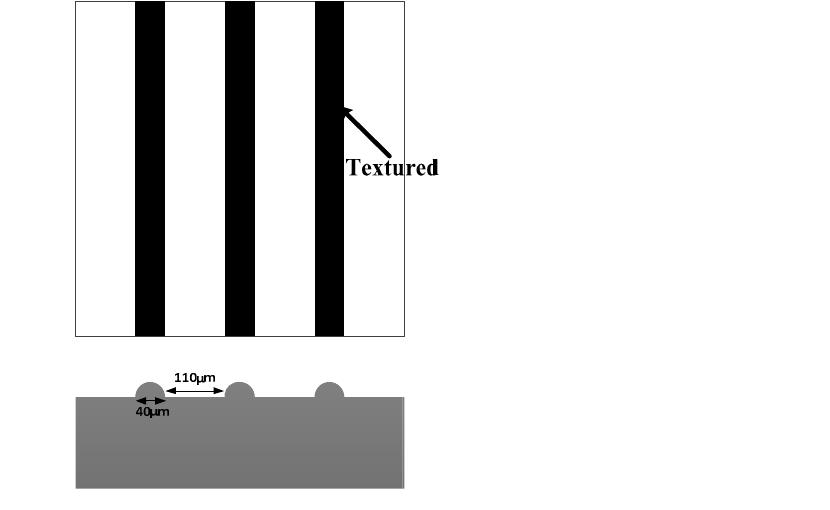
Figure 1. Schematic diagram of the cross-sectional area of the laser textured surface. Table 1. Laser processing parameters used in this work.